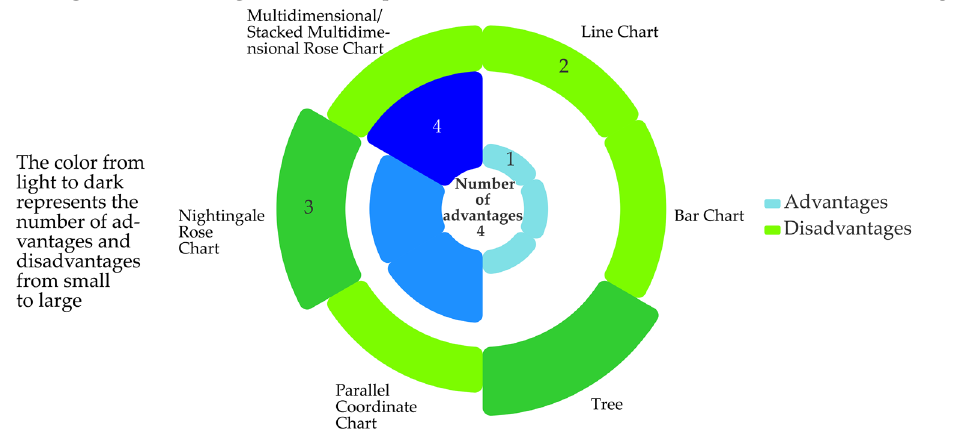
Figure 4. Advantages and disadvantages of the six graphics—stacked multidimensional rose chart. (‘1’, ‘2’, ‘3’, and ‘4’ here indicates how many advantages the relevant graph method has, and details are in Table 2.)